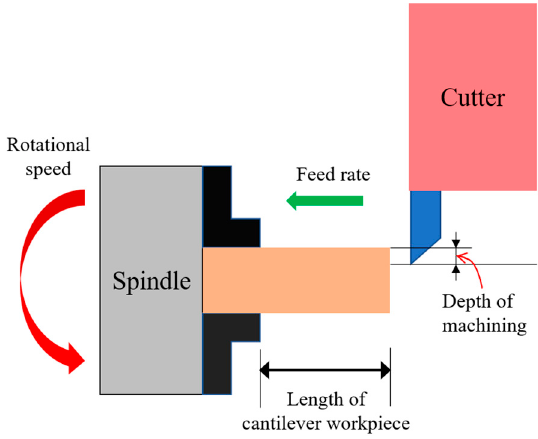
Figure 1. Schematic illustration of turning parameters.